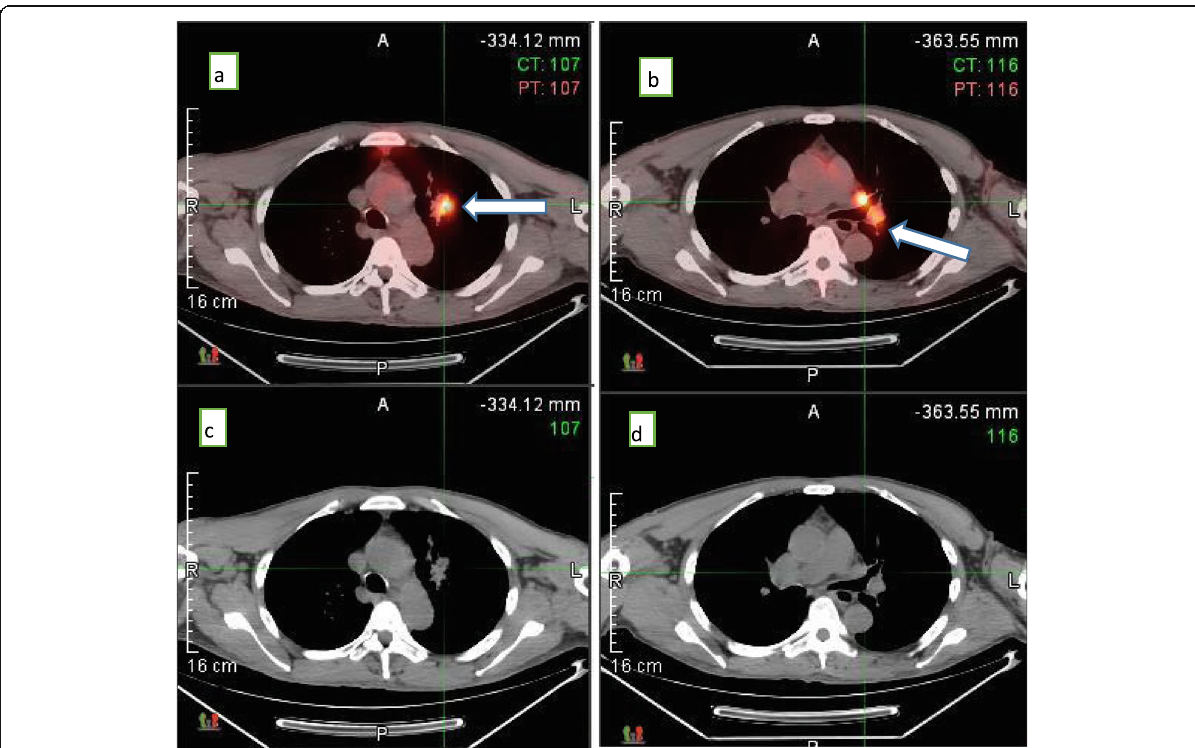
Fig. 2 ( a-d ) 72-year-old male with recurrent lung tumor post therapy 18F-FDG PET/CT revealed 3.6 cm AP×2.5 cm wide medial left upper lobe (SUV max 4.9) speculated mass with surrounding non FDG avid atelectasis (arrow). Contiguous left hilar metastatic lymphadenopathy (SUV max 4.9) was detected ( a, b ). C T revealed atelectasis measuring 3.6 cm AP×2.5cm wide at the medial left upper lobe with no hilar metastatic